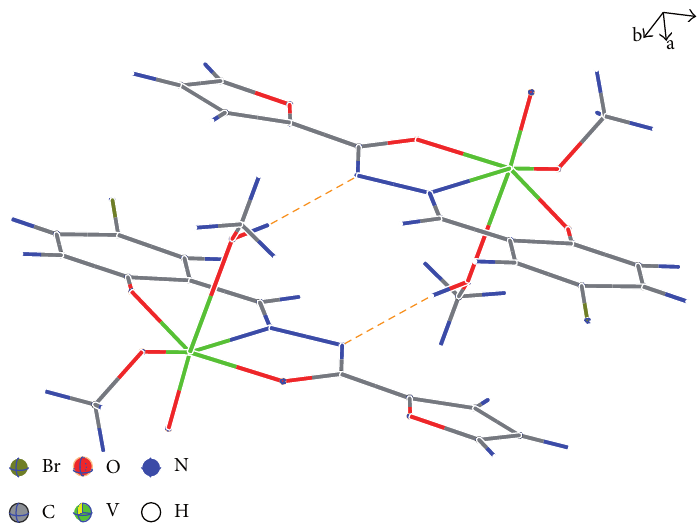
F 4: e hydrogen-bonded structure of the complex 3 .